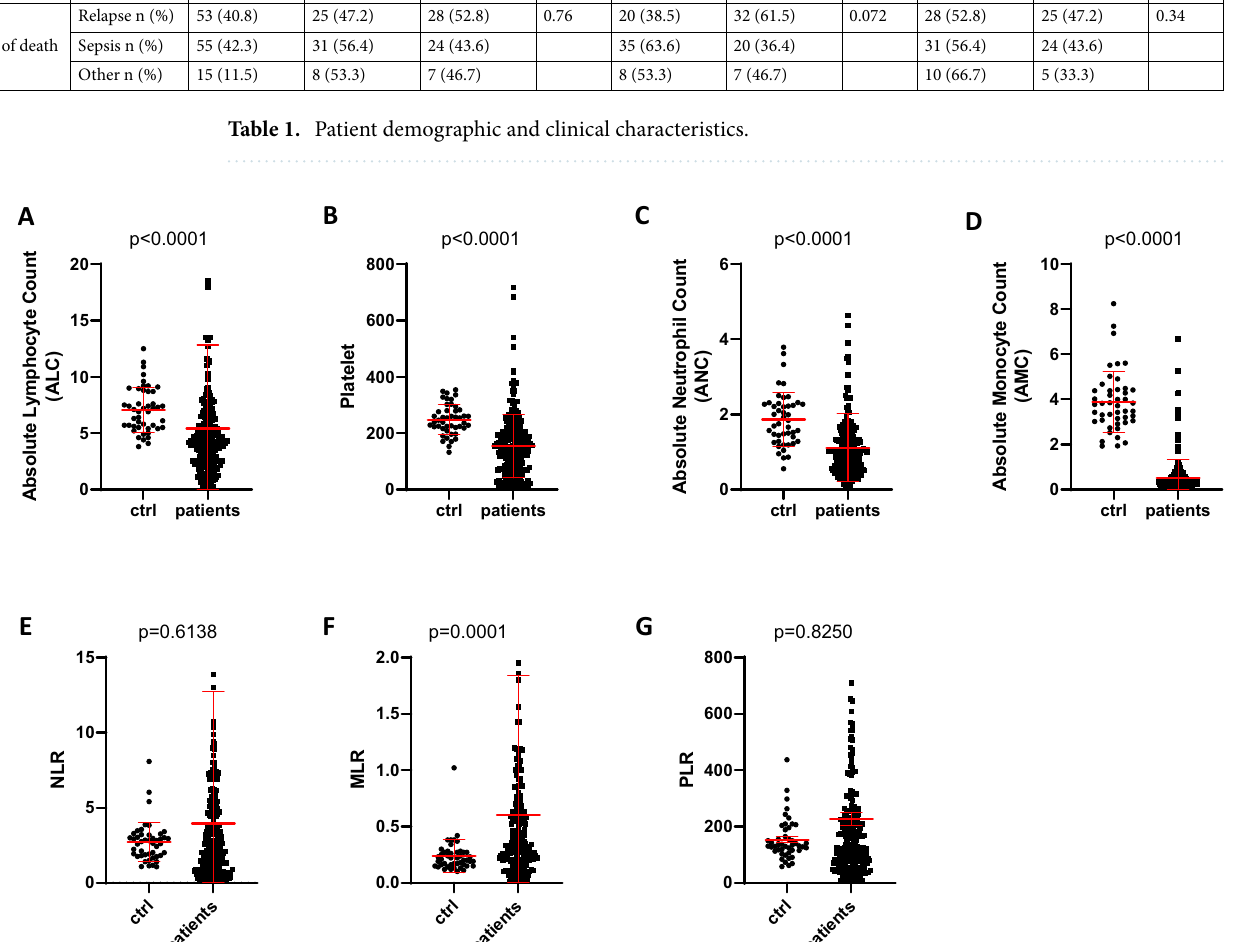
group ( p = 0.009) or very high DRI group ( p = 0.011) (Fig. 2). Analyzing different types of conditioning regimen (MAC vs. sequential including patients with refractory AML vs. RIC) no significant differences were detected between NLR ( p = 0.18), MLR ( p = 0.63) or PLR ( p = 0.34). With regard to different diseases, significant differences became apparent for MLR ( p = 0.044), but not for NLR ( p = 0.054) or PLR ( p = 0.094) (Table 1). Considering age, sex, HLA matching, ECOG, body mass index (BMI) pre-HSCT, CD34 + cells (× 10 6 )/kg in the graft, GVHD prophylaxis (Alemtuzumab vs. ATG vs. other), HCT-CI score, no statistically significant